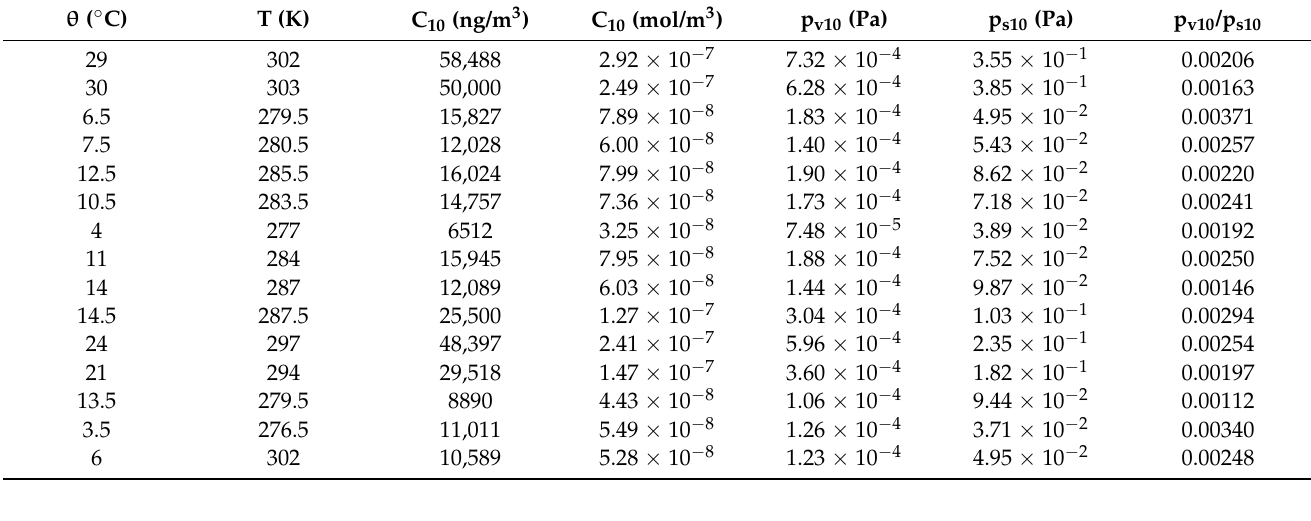
Table 3. Hg vapor and saturation pressures estimated from the concentration C 10 .